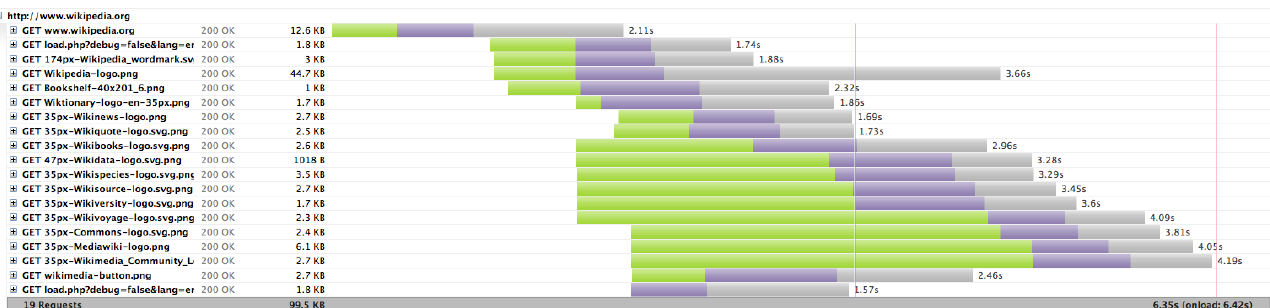
Figure 2. Waterfall diagram for the Wikipedia site. (Color legend for times: green – connect , purple – wait , and gray – receive ).